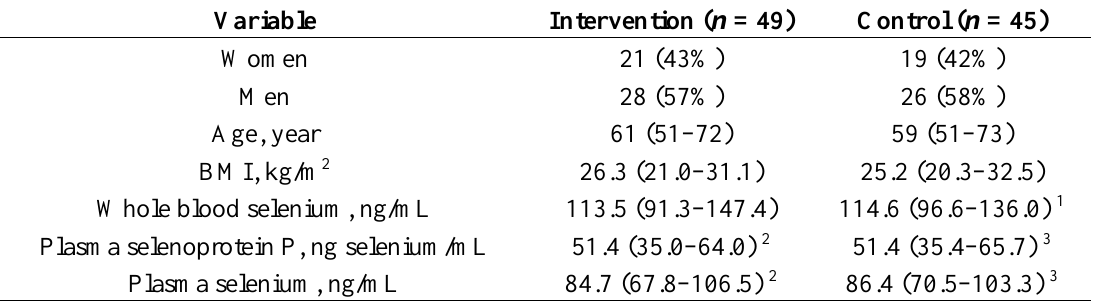
Figure 1. Flow diagram of the recruitment, randomization, and study flow. Table 1. Baseline characteristics presented as number (percentage) or median (5–95